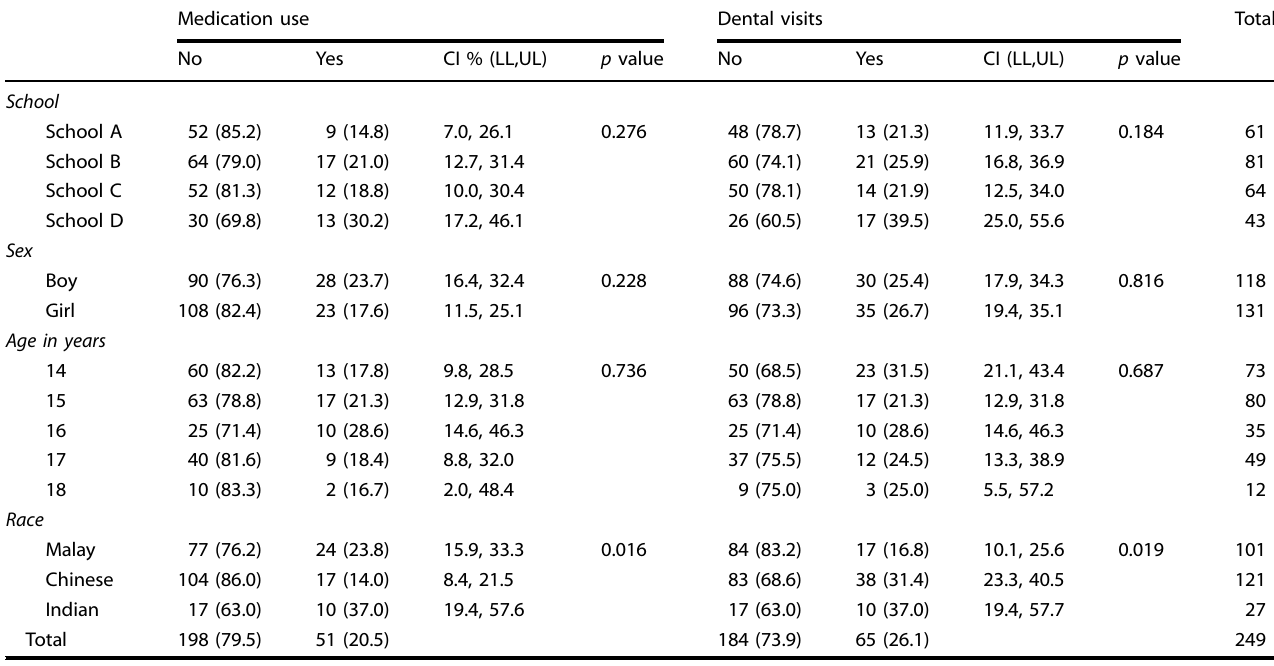
Con fi dence interval for proportion of students who used medication- lower limit-15.7, upper limit- 26.0. Con fi dence interval for proportion of students who visited dentist- lower limit-20.8, upper limit-